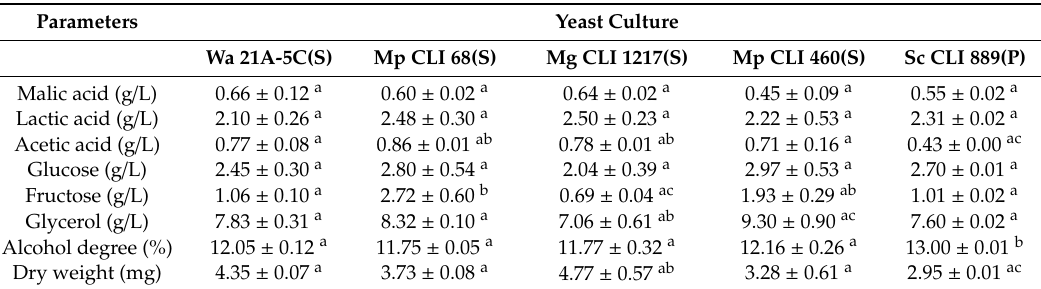
Table 2. Oenological parameters and cell dry weight for the best non- Saccharomyces / S. cerevisiae sequential combinations to reduce ethanol concentration in